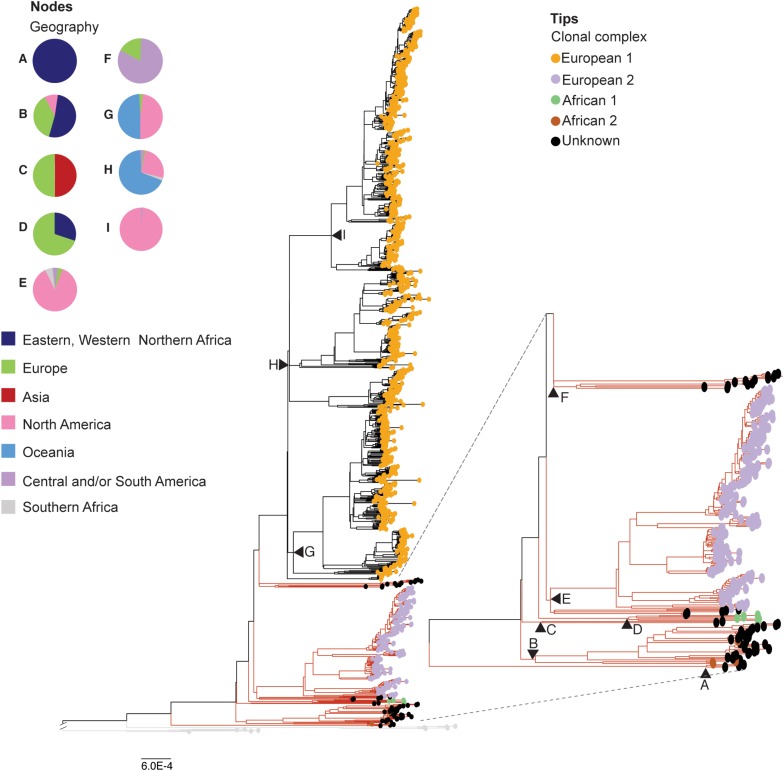
Phylogenetic reconstruction of the reduced dataset of Mycobacterium bovis genomes (n = 1,201). Maximum likelihood phylogenetic tree based on single nucleotide polymorphisms (SNPs) of 1,201 Mycobacterium bovis genomes, using Mycobacterium caprae and Mycobacterium orygis as outgroup. Phylogenetic tree colored based clonal complexes (CC) at the tips. Clonal complexes (circled tips): European 1 (Eu1) in orange, and European 2 (Eu2) in purple, African 1 (Af1) in green, African 2 (Af2) in brown, Unknown CC in black. Black triangles: main nodes A-I, with corresponding geographic origin of M. bovis genomes emerging from each node depicted by the pie charts. Branch lengths of outgroups (in light gray branches) were reduced to improve visualization of the figure. Red branches indicate a subtree that was magnified to improve visualization. Phylogenetic tree was generated using IQ-Tree with 1,000 bootstrap replicas and annotated using Iroki (Moore et al., 2019) and Adobe Illustrator. Bootstrap replicas of discussed nodes are all ≥ 95% and can be visualized in Supplementary Figure S2. Bar shows substitutions per nucleotide.